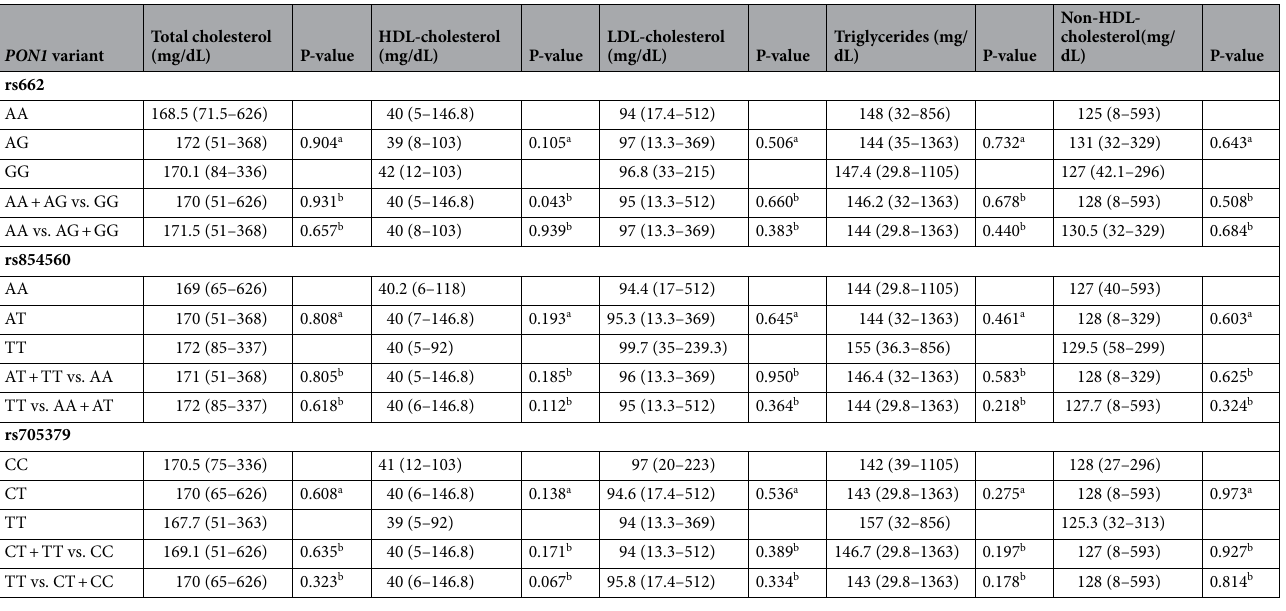
Table 2. PON1 SNVs and serum lipid parameters in HD patients. a Kruskal-Wallis test for comparison between genotypes. b Mann-Whitney U test for comparison in the specified mode of inheritance.